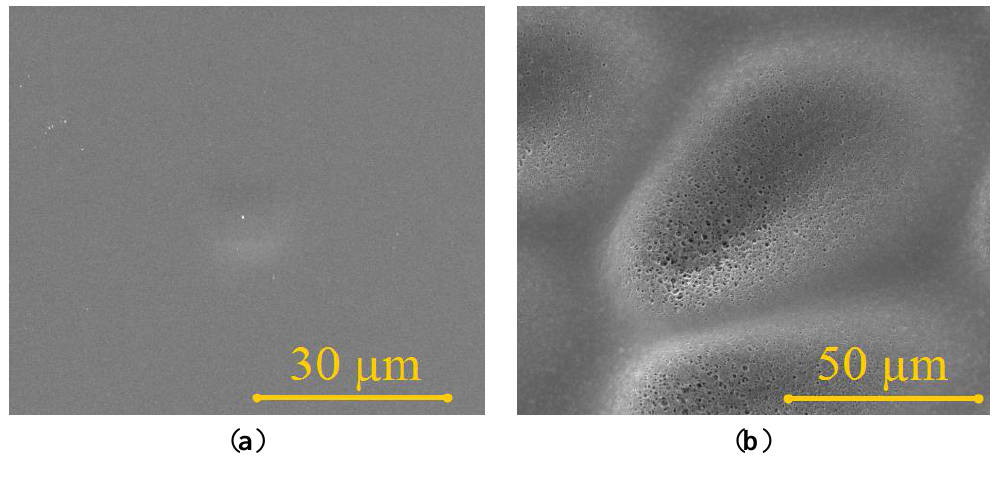
Figure 4. Surface morphology of ( a ) top and ( b ) bottom surface of PES membrane.